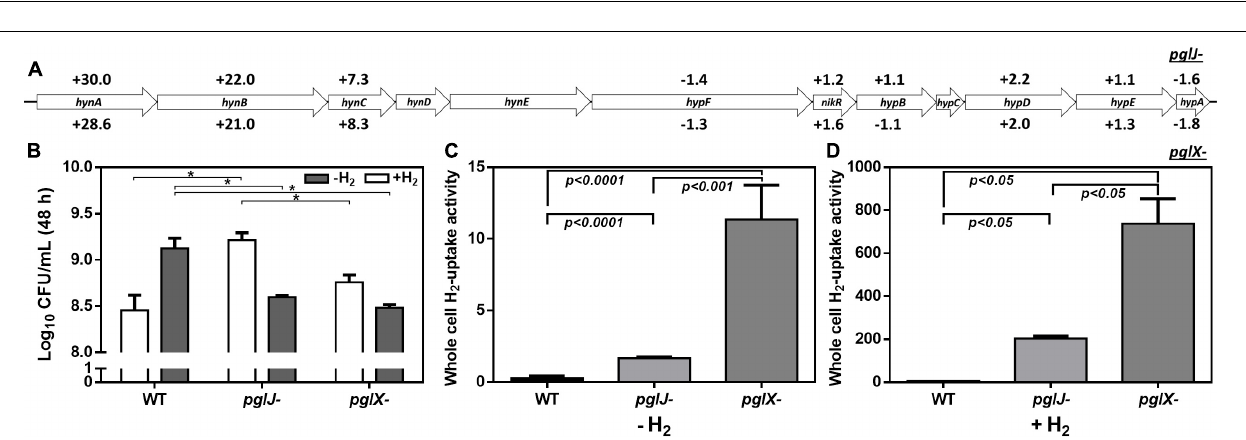
FIGURE 7 | Elevated hydrogenase levels in Cff - pgl mutants correlate with increased H 2 uptake. (A) Gene arrangements of hyn and hyp clusters in Cff ATCC 27374 with LFQ proteomic protein abundance in pgl mutants vs WT are shown. Protein fold changes of pglJ- and pglX- with respect to WT are indicated above and below each gene respectively. Genes with no values associated had no coverage in our proteomics data analyses. Only HynABC showed significant protein level increases when compared to WT. (B) Effect of H 2 on microaerobic growth of Cff WT, pglJ -, and pglX - strains. The data set is derived from three biological replicates (with two technical replicates each) of cells grown under the indicated condition. Number of cells obtained after 48 h of growth is represented by Log 10 colony forming units per mL (CFU/mL). The error bars represent the standard error within each group. (C,D) Whole cell H 2 -uptake of Cff WT, pglX-, and pglJ - strains. Cff was grown on BHI agar in microaerophilic conditions for 24 h at 37 ◦ C in 10% H 2 (+H 2 ) or absence of hydrogen (–H 2 ). Whole cell H 2 -uptake activity is expressed as nanomoles of